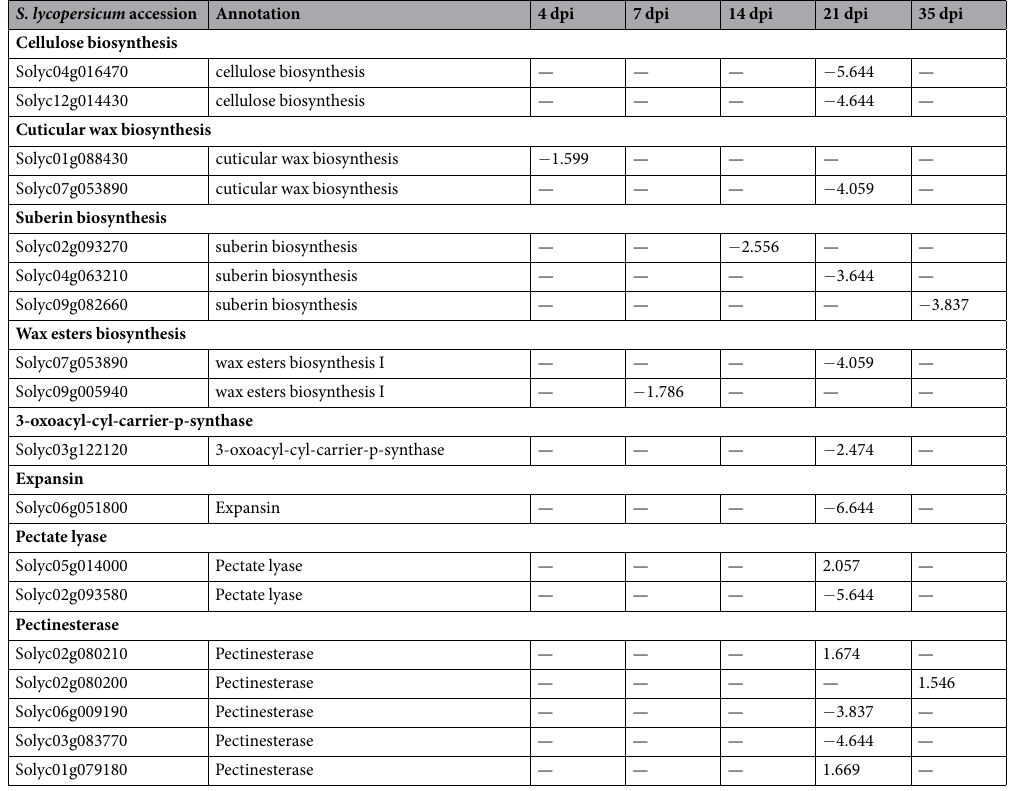
Table 5. List of differentially expressed cell wall pathway genes in Sw-7 compared to the S-line after TSWV Phytohormones are signal molecules produced within the plant cells that regulate plant growth and devel- opment 22 . Plant hormones can vary as a response to pathogen infection. During virus infection, many plant hormone-signaling molecules are either suppressed or induced, which, in turn, affect normal plant growth, resulting in disease-like appearance, such as developmental defects and/or plant stunting 23 . Auxins have key roles in determining patterns of plant development and growth, which has four families: glutathione S-transferases, auxin homeostasis proteins like GH3, SAUR genes, and Aux/IAA. In Arabidopsis , auxin (Aux/IAA) mutant constitutively represses auxin response that leads to suppression of plant growth 24 . Upon TSWV infection, the S-line plants showed a reduction in plant growth, which corresponded with the reduction in auxin pathway gene expression. In studying the mechanism of resistance to TYLCV, Yang and colleagues 25 identified a MADS-box transcription factor as one of the candidate genes for Ty-2 resistance in tomato. Interestingly, in the present study, MADS-box genes were induced in the Sw-7 resistance to TSWV (Supplementary Fig. S3), implicating a possible involvement of a MADS-box gene in Sw-7 resistance. Protein kinases (PKs) play a major role in disease resistance through phosphorylation of the interacting pro- teins to trigger active or functional processes. Although there are only a small number of PKs induced in the Sw-7 plants, previous studies 26,27 have shown that a Pto-like serine/threonine kinase protein 26 was induced in tomato with resistance to a bacterial disease. A large number of PK genes induced in the S-line during the virus infection may play a function by activating currently unknown susceptible host factors or downstream signaling compo- nents to promote symptom expression. A higher number of PK genes induced in the S-line plants pointed to a likely stronger antiviral response in the infected plants as they attempt to fight back for survival from the virus infection. Our analysis revealed the induction of 10 microRNAs in the S-line. Non-coding RNAs (ncRNAs), including microRNAs and long ncRNA, play key roles in regulating gene expression in plants and animals 28 . Such induction may result from a physical binding (sequester) of the TSWV-encoded suppressor protein (NSs) to microRNAs, leading to an elevated expression of the target genes and as a consequence enhanced virus accumulation in the S-line. NBS-LRRs are a major category of disease resistance genes (R-genes) in plants, which have been classified into two sub-families: TIR-NBS-LRR and CC-NBS-LRR 29 . Typically, there are hundreds of diverse NBS-LRR genes in a plant genome 30 . However, in the current study, only two NBS-LRR genes showed differential expression, both down-regulated in the Sw-7 line at 21 dpi, suggesting NBS-LRR genes are not likely the candidate resistance gene for Sw-7 against TSWV infection. Induction of PR genes leads to local and systemic defense gene activation, which could restrict virus move- ment. Previous study revealed PR proteins could be involved in resistance against fungi, bacteria and viruses 31 . A